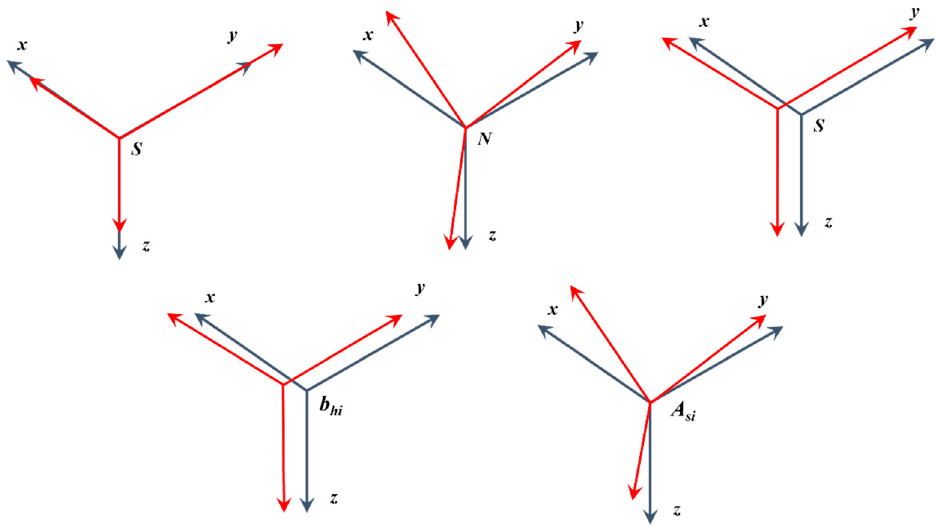
Figure 1. Effect of magnetometer error.